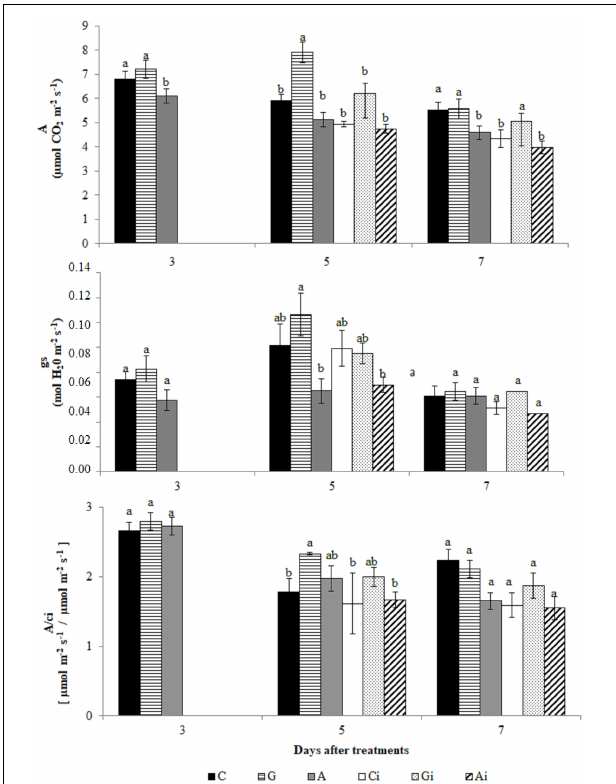
FIGURE 10 | Evaluation of photosynthesis rate ( A ), stomatal conductance ( gs ) and A/c i in coffee leaves treated with the plant resistance inducers (PRIs) Greenforce CuCa (G), ASM (A), and control (C) and inoculated with H. vastatrix (i). Inoculation occurred 3 days after treatment with PRIs. The means from the treatments, at each evaluation time, followed by different letters were significantly different ( p ≤ 0.05) according to Tukey test. Bars represent the standard error.